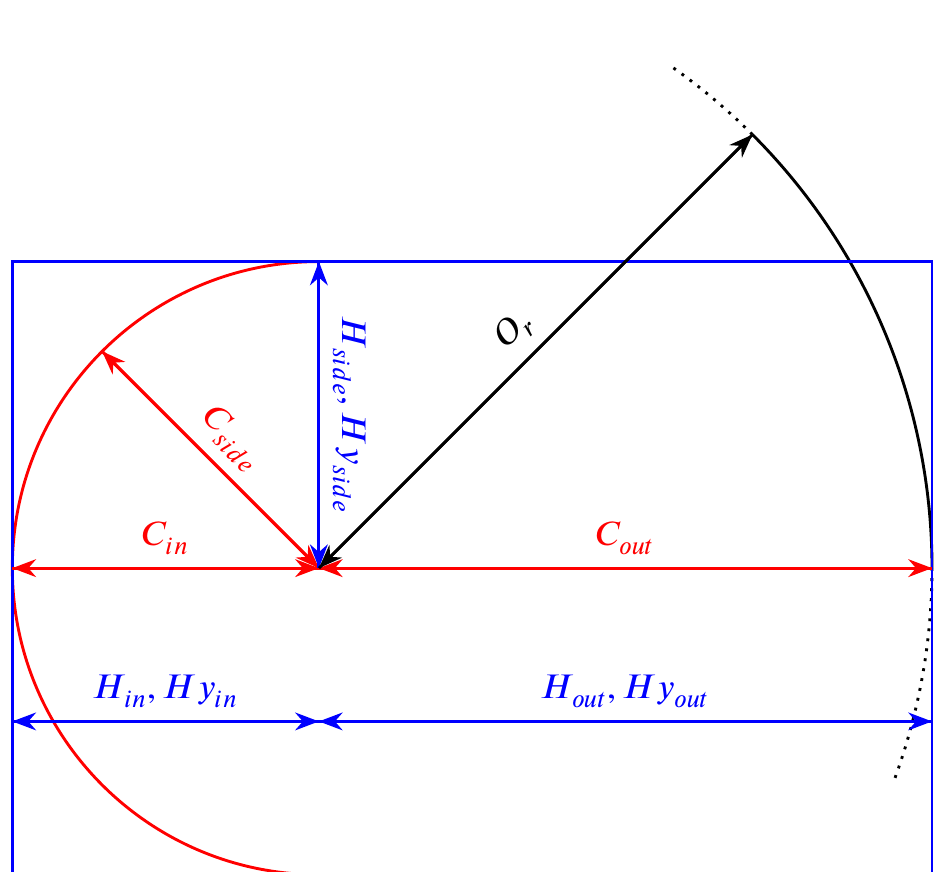
Figure 4. The geometric parameters for different mesh